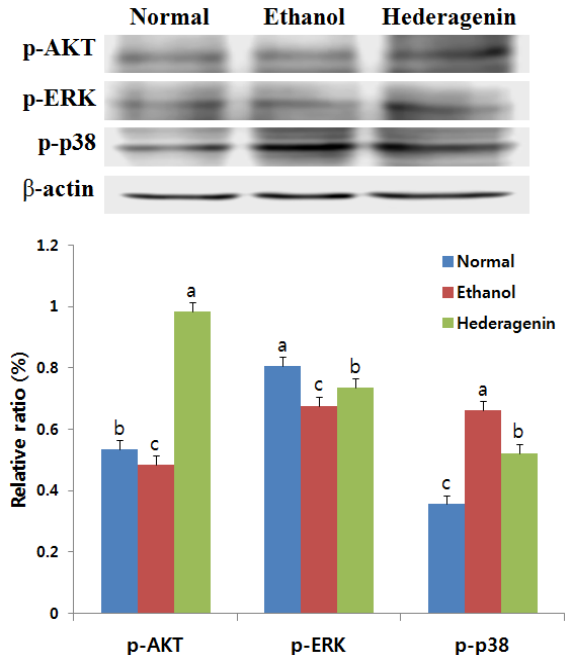
Figure 6. Effects of hederagenin on the expression levels of p ‐ AKT, p ‐ ERK, and p ‐ p38 in the liver of ethanol ‐ exposed rats. Results are expressed as the means ± SD. Significant differences ( p < 0.05) are represented using different letters.